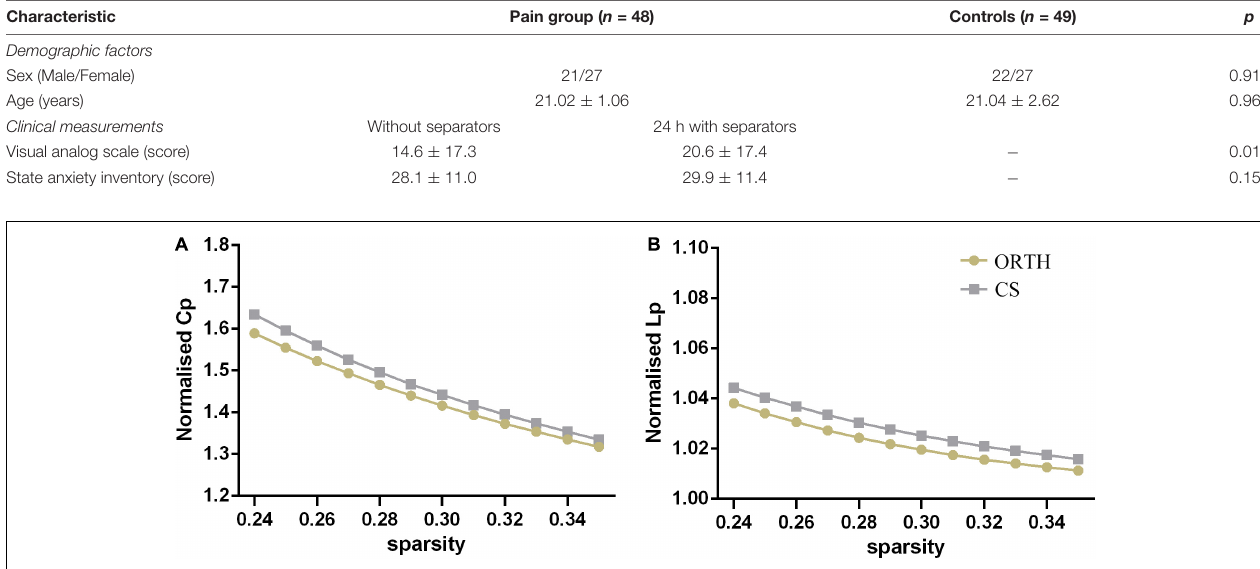
TABLE 1 | Demographics and clinical data of participants with experimental orthodontic pain and control